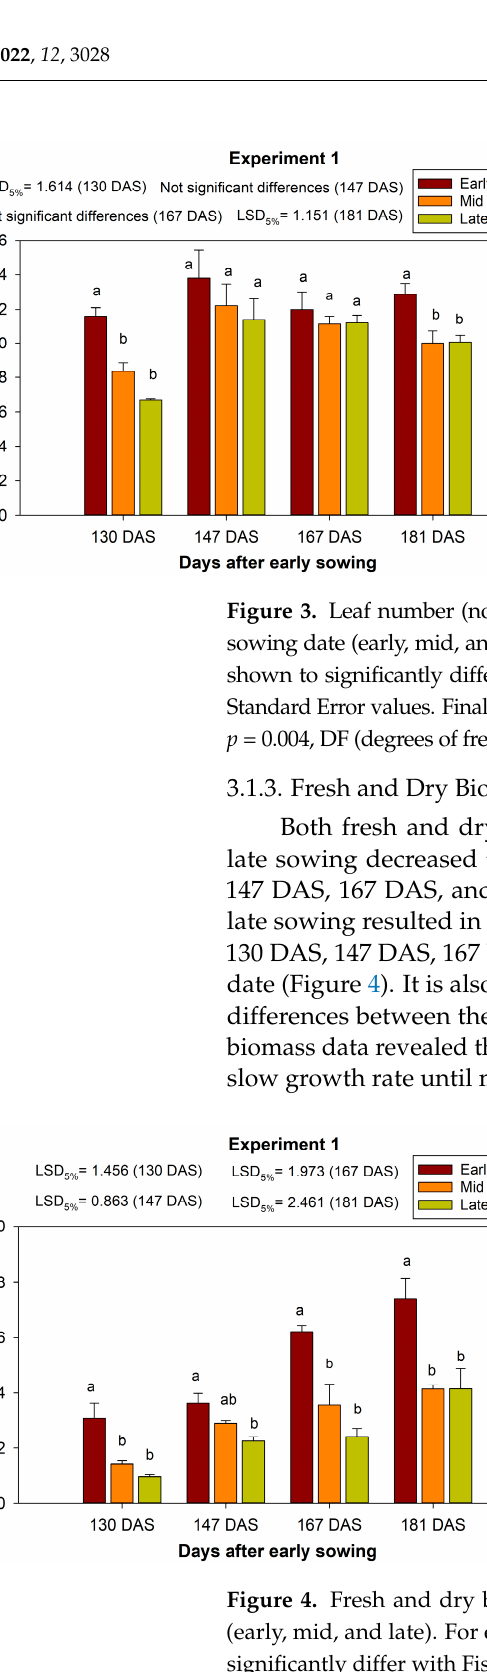
Figure 4. Fresh and dry biomass (g plant − 1 ) of bristly oxtongue as affected by nitrogen fertilization and chitosan application. For each sampling date, bars followed by the same letters were not shown